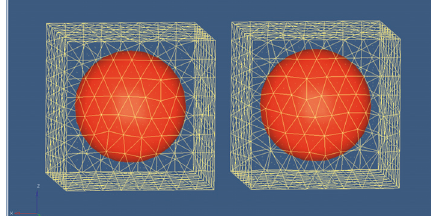
Figure 6: Two spheres are enclosed by two equivalence surfaces.